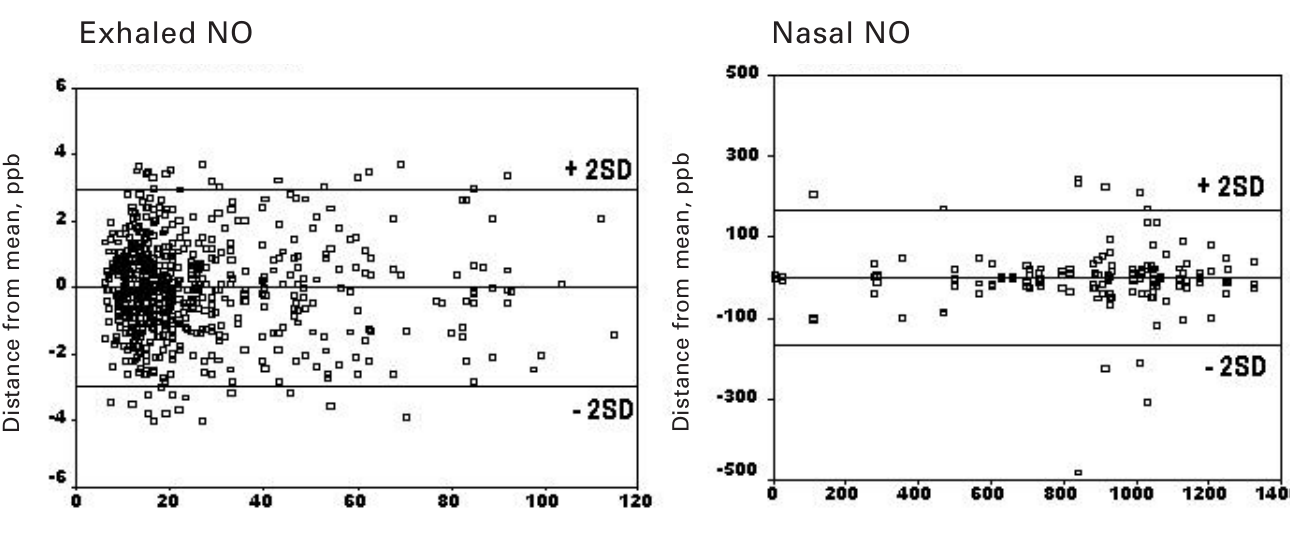
Mean FENO, ppb Mean NO, ppb